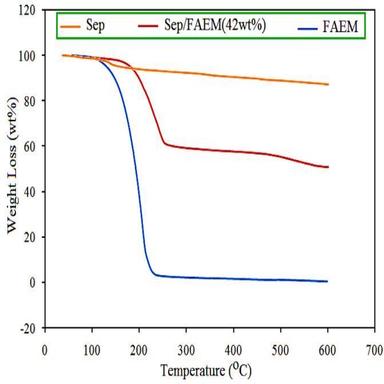
(a) Temperature variations at inner surface location of the cement plastered wall with/without Sep/FAEM composite. (b) Temperature variations at inner center location of the cement plastered room with/without Sep/FAEM composite.